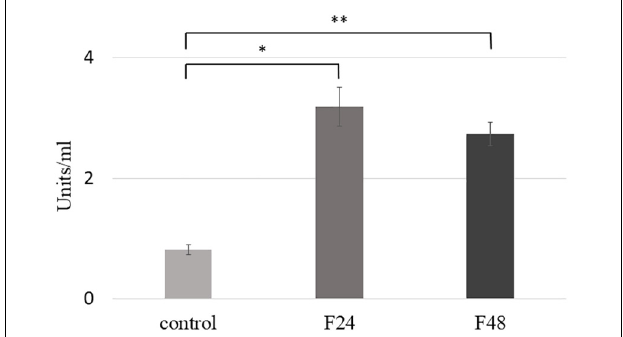
FIGURE 6 | Phospholipase A2 (PLA2) activity in the hemolymph of G. mellonella larvae after infection with C. coronatus. The measurement was made using sPLA2 Activity Kit (Enzo Life Science). Data are presented as means and standard deviations; ∗ p = 0.0002, ∗∗ p = 0.0001 (Student’s t -test, p ≤ 0.05). Control, non-infected, healthy larvae; F24, larvae sampled immediately after 24-h exposure to fungal infection; F48, larvae sampled 24 h after 24-h